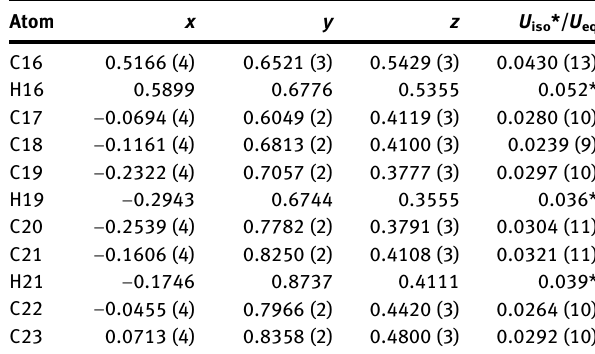
Table  : Fractional atomic coordinates and isotropic or equivalent isotropic displacement parameters (Å 